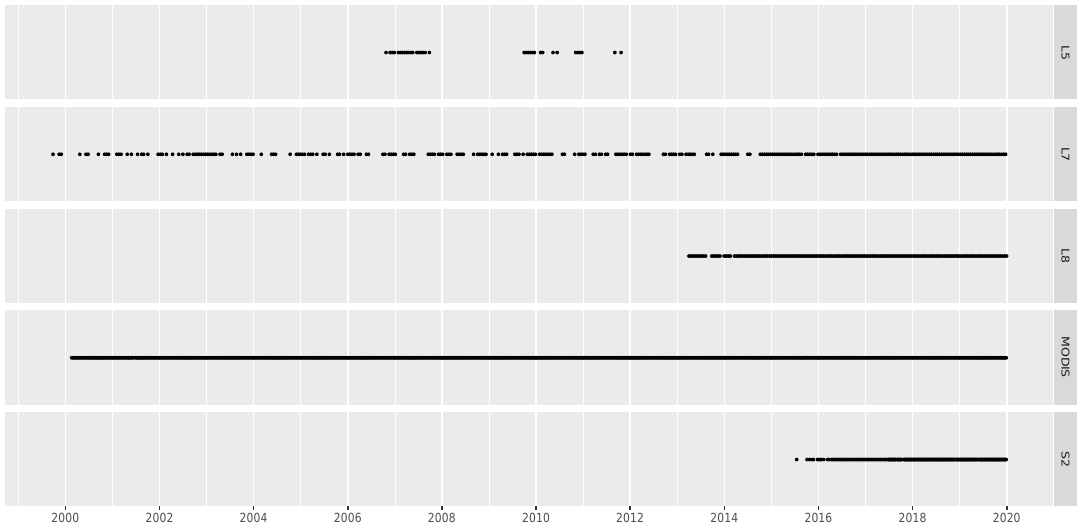
Figure A1. Available observations in Google Earth Engines for the region of interest from the Landsat, MODIS and Sentinel-2 satellites over the 1999–2019